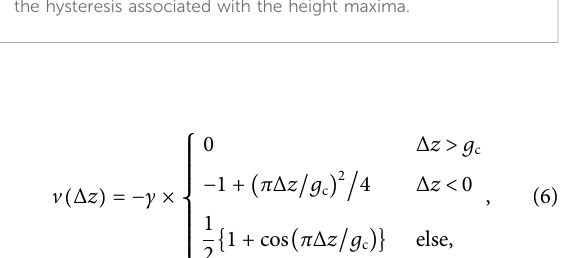
FIGURE 3 Dimensionless interfacial stress σ 0 / σ max as a function of the dimensionless displacement d / d p during approach and retraction for elastomers of different thicknesses t , that is, qt = ∞ , 2, and 1, where q = 2 π / λ . Here, d p is the displacement required to break the contact in the JKR limit. The surface energy γ is kept constant at v full ela ( t (cid:1) ∞) /4 leading to the thickness-dependent reduced surface energies stated in the labels. The inset highlight the hysteresis associated with the height